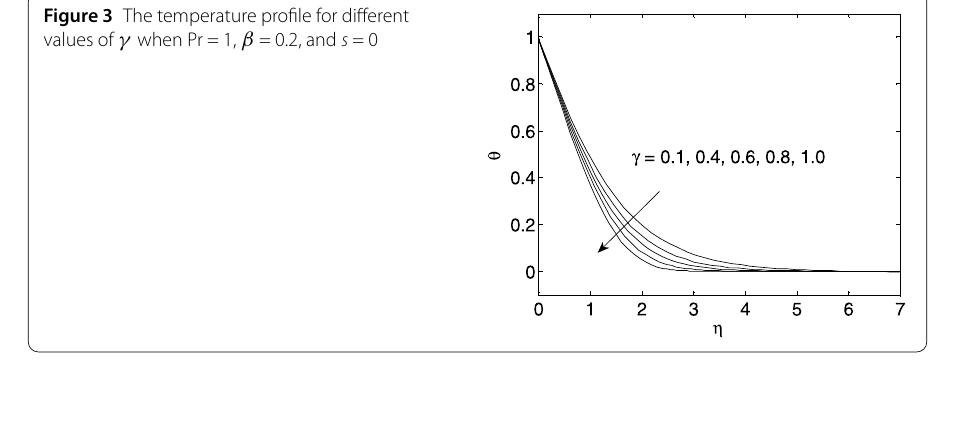
Figure 4 The temperature profile for different values of Pr when β = 0.1, γ = 0.2, and s =